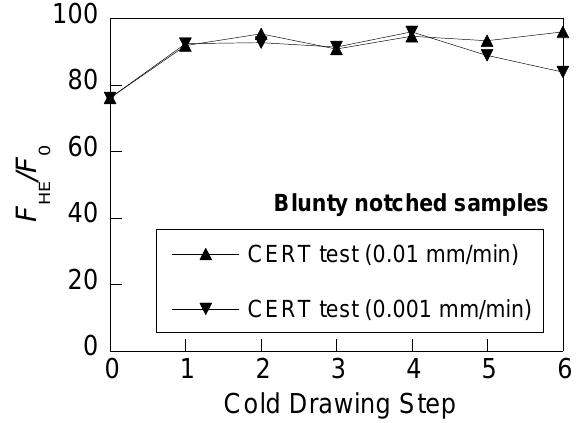
Figure 8. Variation with the cold drawing degree of the hydrogen embrittlement (HE) susceptibility of the progressively drawn steels for the two loading rates.